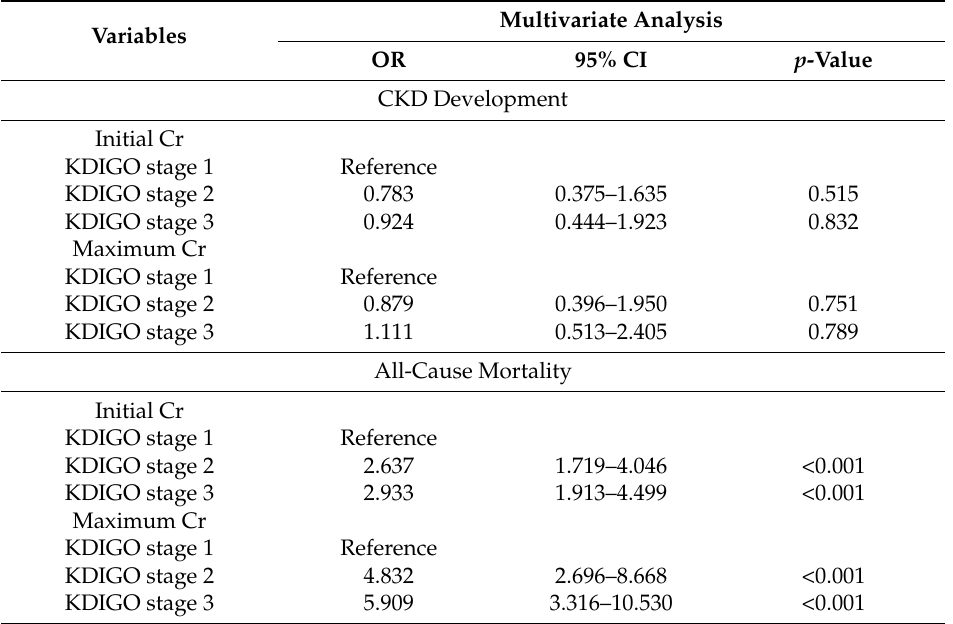
Table 2. Adjusted odds ratios of the AKI stage for CKD development in patients with sepsis-induced AKI.